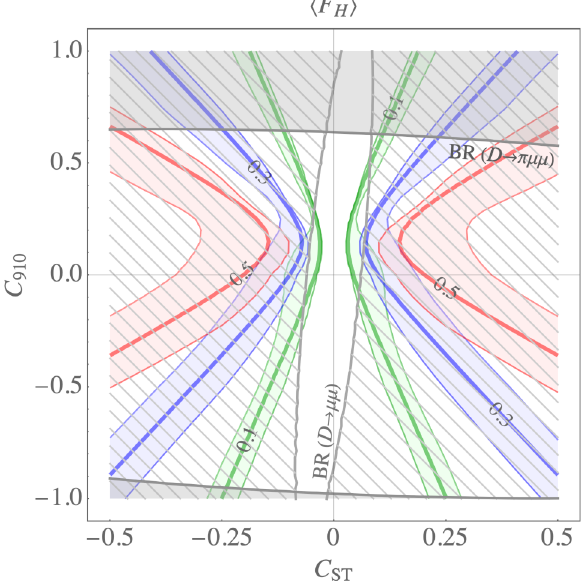
Figure 10 . Contours (blue, red, green) of the observable h F H i , as defined in the text, in the C ST – C 910 plane. The bands around the contours signify the theory uncertainty. The grey lines and shaded areas indicate the exclusion from the LHCb bounds on the branching ratios B ( D 0 → µ + µ − ) [52] and B ( D + → π + µ + µ − ) [38] as